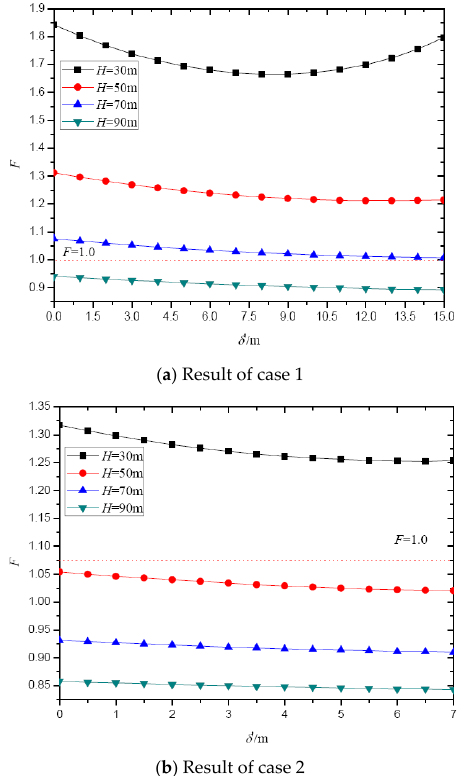
Figure 9. Relationship between safety factor and crack depth under different slope height.